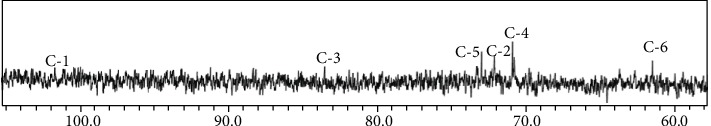
The 13C-NMR spectrum of G. frondosa extracted β-glucan at room temperature in deuterated Me2SO and D2O (6 : 1) solvents.